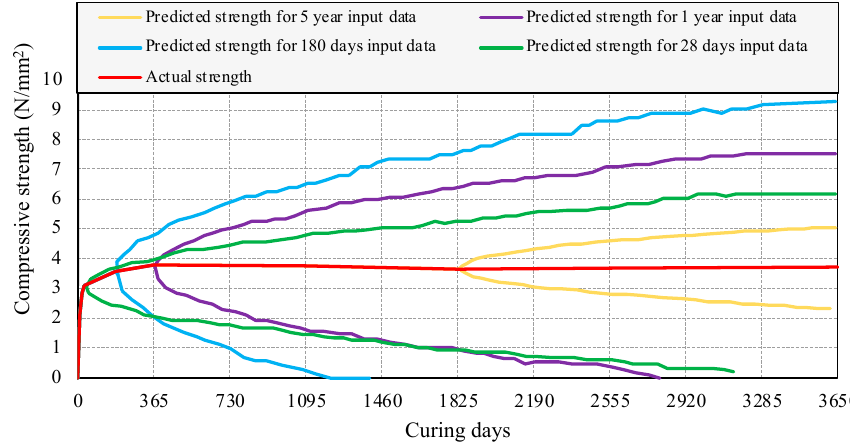
Figure 7. SSR model results for different input data.